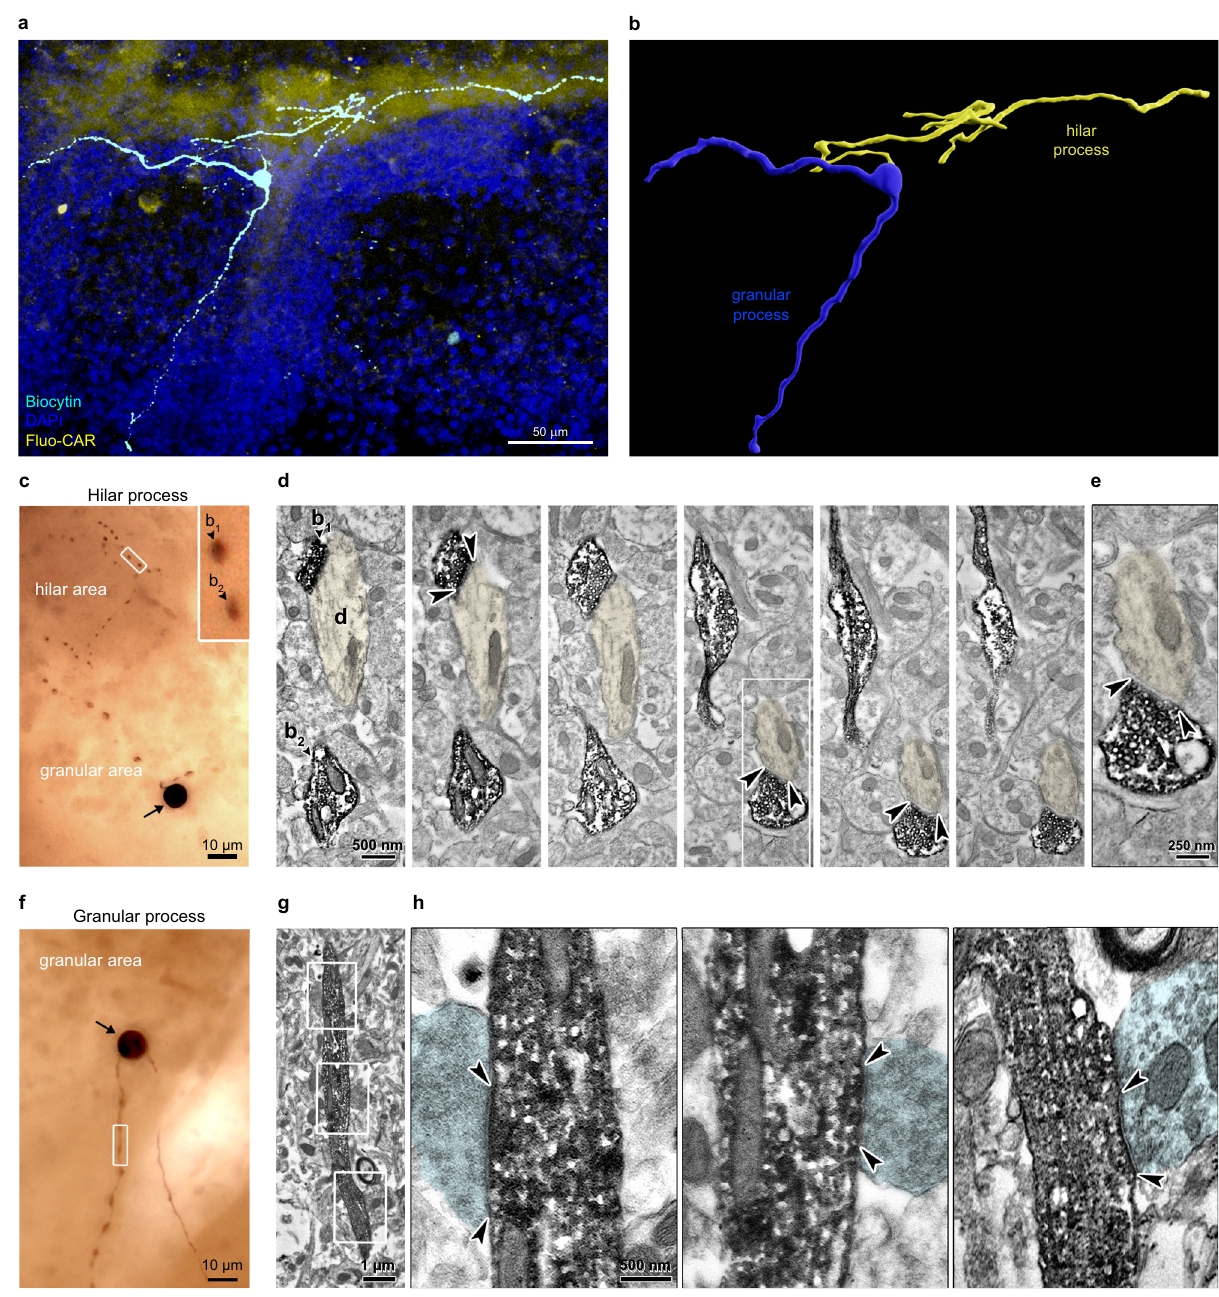
Fig. 6 Morphological properties of granule cells in the Islands of Calleja. a , b A representative granule cell is shown in the Islands of Calleja. This neuron was fi lled with biocytin during whole-cell patch-clamp recording in the acute coronal slice preparation. The same slice was live-stained with 300 nM Fluo- CAR for the correlated visualization of drug-binding sites and the morphological features of the granule cell. Note that the arborization of the granule cell strictly follows the unique shape of the Islands of Calleja. One of its processes preferentially branches in the hilar subregion, whereas two other major processes arborize in the granular subregion. b 3D reconstruction of the same granule cell. The neuronal process that enters the Fluo-CAR-rich hilar subregion is marked in yellow and hereinafter referred to as the hilar process. The other neurites that remain restricted to the granular subregion are termed the granular processes (blue). c – h Correlated light and electron microscopy was used to determine the integrity of the acute slice preparations used for PharmacoSTORM staining and helped to determine the morphological features of hilar and granular processes. c A representative light micrograph of a biocytin- fi lled granule cell soma (arrow) in the granular subregion of the Islands of Calleja and its hilar process that has numerous varicosities within the hilus. Inset shows two bouton-like structures (b 1 , b 2 ) at higher magni fi cation from the boxed area. d Electron microscopic images of consecutive serial sections demonstrate that the two boutons (b 1 , b 2 ) are fi lled with synaptic vesicles, and form symmetric synaptic specializations (arrowheads) on a dendrite ( d , pseudo-colored in yellow). e High-magni fi cation electron micrograph of the synapse from the boxed area in ( d ). f Another biocytin- fi lled granule cell (arrow) is shown together with its granular process. g Electron microscopic image of the boxed area in ( f ). h High-magni fi cation electronmicrographs of boxed areas in ( g ), showing afferent boutons (pseudo-colored in cyan) forming chemical synapses (arrowheads) on the granular process of the granule cell. Panels display representative micrographs from three biologically independent